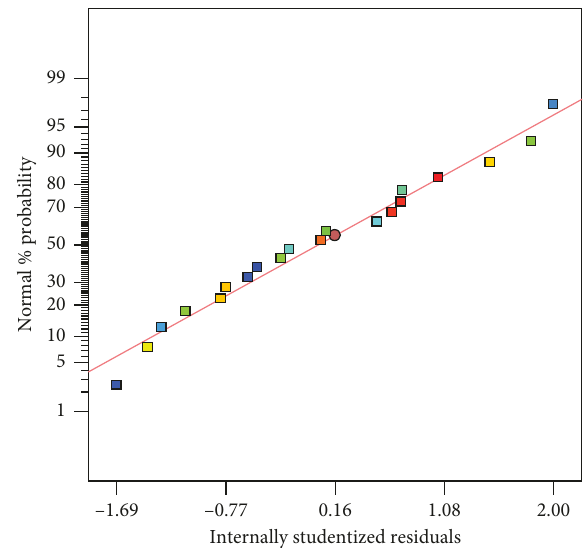
Figure 2: Normal plot of the